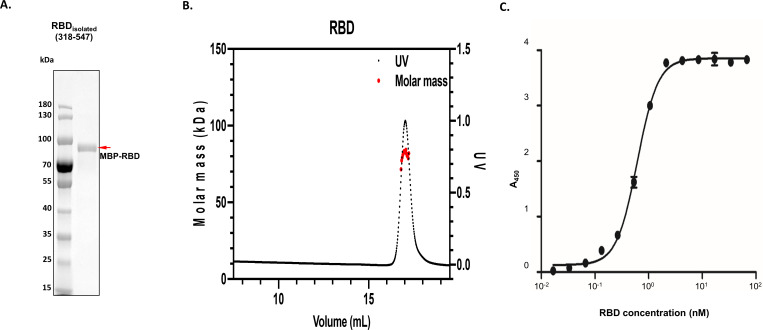
Homogeneity of receptor binding domain (RBD) isolated sample and validation of angiotensin-converting enzyme 2 (ACE2):RBD complex formation.(A) Images of denaturing polyacrylamide gel electrophoresis of purified RBD isolated (maltose-binding protein [MBP]-tagged) are shown along with its molecular sizes highlighted with red arrow, alongside protein standards. (B) Molecular weight analysis of expressed MBP-tagged RBD by size exclusion chromatography – multiple angle light scattering. The measured molecular weight (kDa) is 81.2 (±4.8%) for RBD. (C) Interactions between ACE2 and RBD represented by the binding curves obtained from enzyme-linked immunosorbent assay experiments as described in 'Materials and methods'. Testing of RBD was performed by adding 100 µL of 10.4 nM ACE2 to a maxisorp plate coated with RBD at varying concentrations.